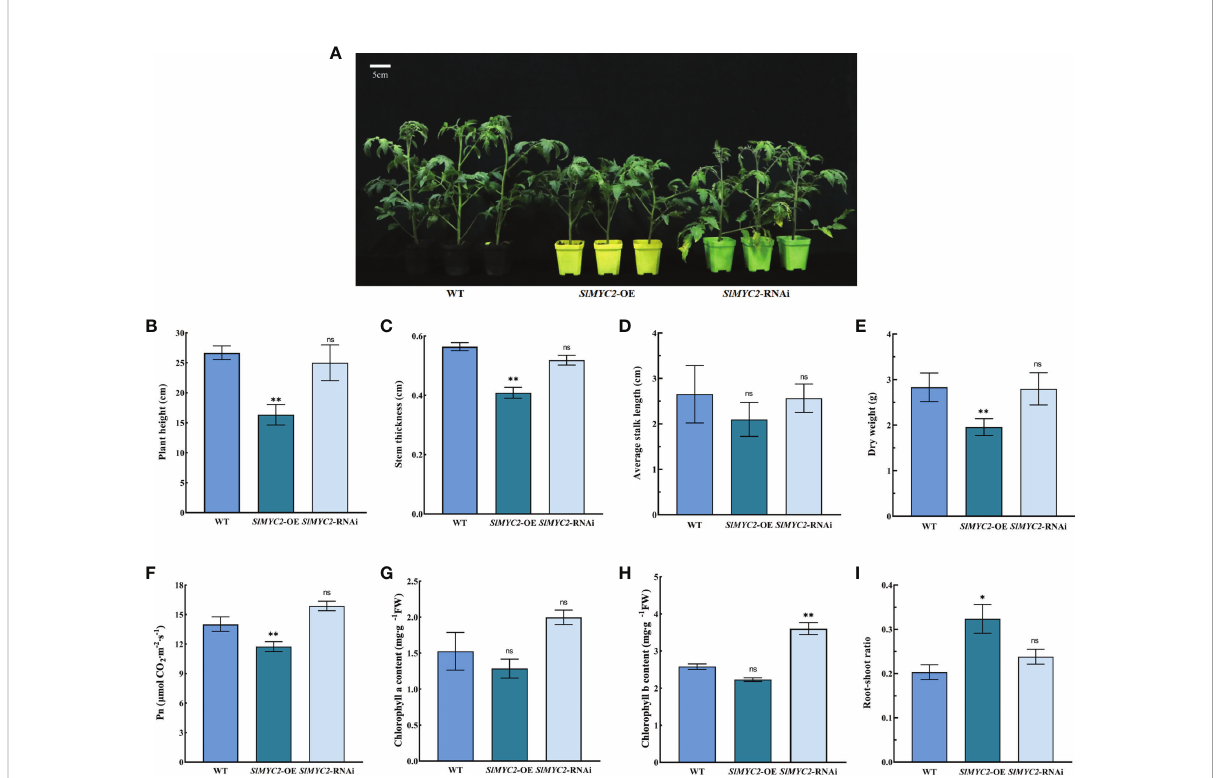
FIGURE 2 Effects of SlMYC2 overexpression and silencing on the growth and photosynthesis of tomato seedlings. (A) Phenotypic of tomato seedlings (5-week-old). (B) Plant height. (C) Stem thickness. (D) Average stalk length. (E) Dry weight. (F) Net photosynthetic rate (Pn). (G) Chlorophyll a content. (H) Chlorophyll b content. (I) Root-shoot ratio. SlMYC2 -OE, SlMYC2 overexpression; SlMYC2 -RNAi, SlMYC2 silenced. Errors are standard deviations for three biological replicates (n=3). Differences between means were analyzed for signi fi cance using Student ’ s t test, *P < 0.05, **P < 0.01. ns, no signi fi cant